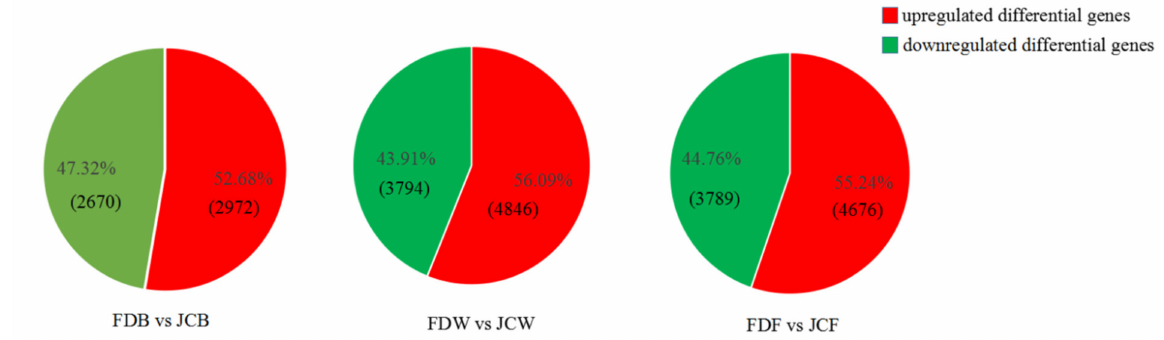
Figure 3. DEGs in each period. Red is upregulated DEGs and green is downregulated DEGs. The number of DEGs is in